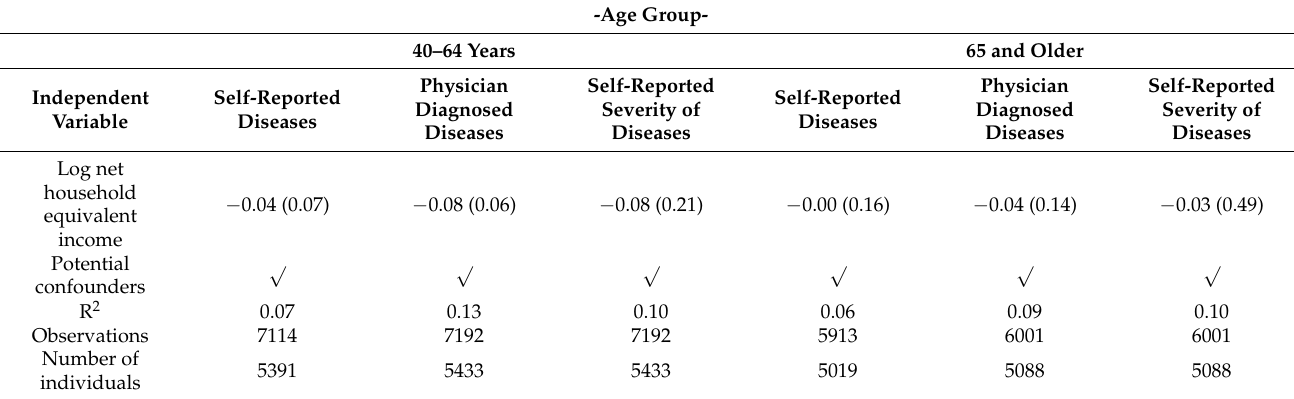
Table 4. Determinants of morbidity. Results of linear fixed-effects regressions (stratified by